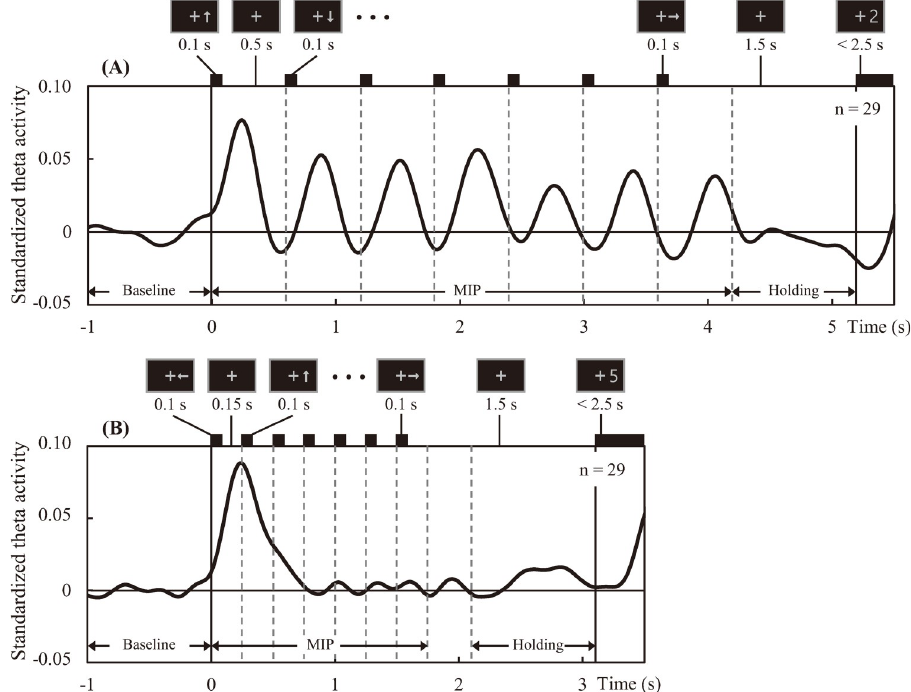
Fig 3. Mean time courses of standardized theta activity across all sensors; in the slow task (A) and fast task (B). Theta activity amplitude was standardized based on mean activity over the baseline period. Vertical lines indicate the onset times of the arrows (memory items) and recall numbers. Durations of presentation and some examples are shown above each time course.